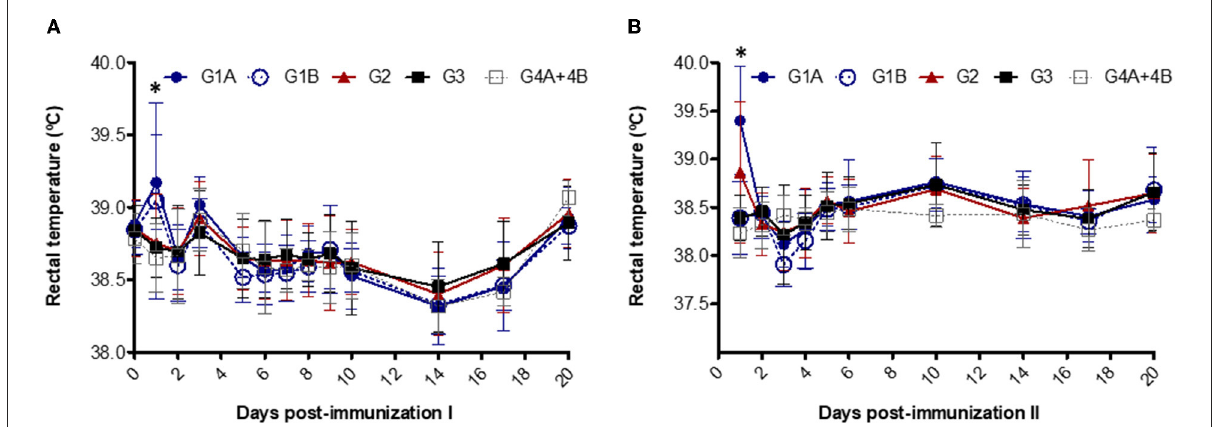
FIGURE1 Rectal temperatures after the first (A) and second (B) immunizations. Immunized groups: Trichobovis administered by subcutaneous (SC; G1A) or intravulvar (IVU; G1B) routes and TrichGuard by SC route (G2). Non-immunized groups received PBS injections via SC (G3, G4A) or via IVU (G4B) routes. Each point represents the mean and standard deviation of the rectal temperature ( ◦ C; Y-axis) measured throughout the experimental time (X-axis; days post immunization). *Asterisk indicate significant differences between vaccinated and non-vaccinated groups.